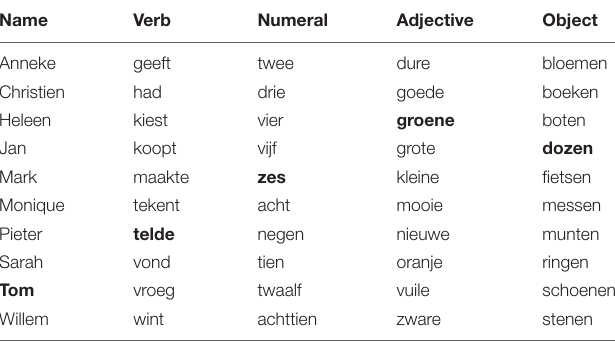
Bold words indicate an example sentence: ‘Tom telde zes groene dozen’ (translation: ‘Tom counted six green boxes’, see Figure 8 ).